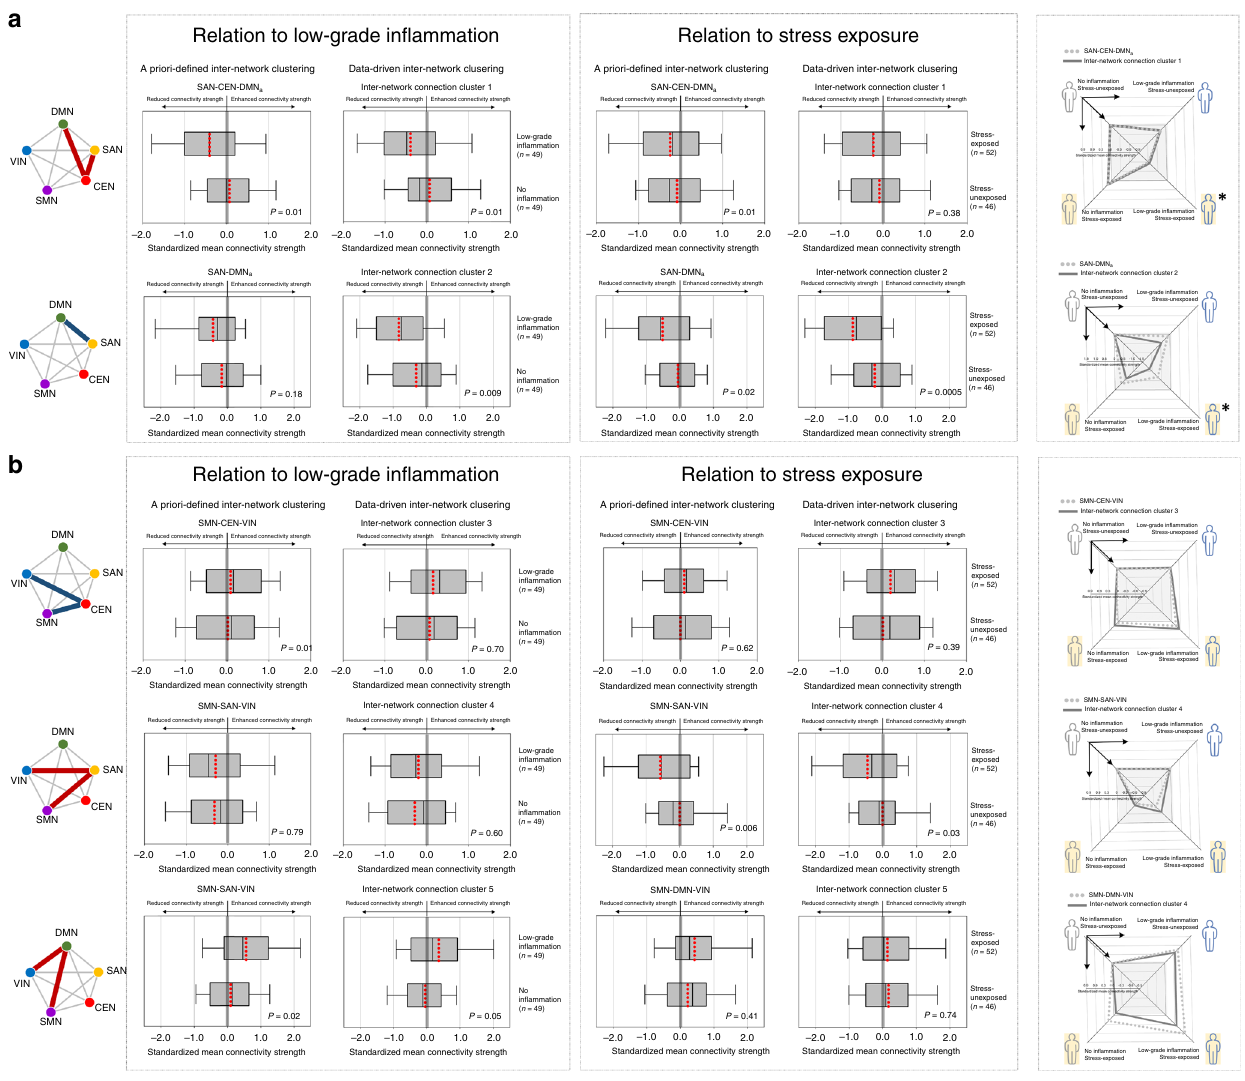
Fig. 4 Results from data set 2: altered inter-network connectivity strength in relation to low-grade in fl ammation and stress exposure. a Box-and- whisker plots show the distribution of standardized mean connectivity strength within the higher-order cognitive network system, including the SAN, CEN, and DMN a between the low-grade in fl ammatory ( n = 49) and the nonin fl ammatory groups ( n = 49) (left box), as well as the stress-exposed ( n = 52) and -unexposed groups ( n = 46) (right box). b Box-and-whisker plots show the distribution of standardized mean connectivity strength for the higher-order cognitive network system and the primary sensory network system between the low-grade in fl ammatory ( n = 49) and the nonin fl ammatory groups ( n = 49) (left box), as well as the stress-exposed ( n = 52) and -unexposed groups ( n = 46) (right box). Box-and-whisker plots represent the mean values (red dotted lines inside boxes), median values (black lines inside the boxes), the inter-quartile range (bottom and top ends of the boxes), and the 10th and 90th percentiles of the data (whiskers). Red and blue lines in the schematic diagram for inter-network connection clusters indicate the positive and negative coupling of networks, respectively. Group differences were calculated using the generalized linear models after adjusting for age and sex. P values (for two- sided testing) in the bar graph are permutation-adjusted P values (10,000 permutations). Radar graphs in panels a and b demonstrate comparisons of inter-network connectivity strength between the nonin fl ammatory/stress-unexposed group ( n = 24) and each of the remaining three groups, including the low-grade in fl ammatory/stress-unexposed ( n = 22), nonin fl ammatory/stress-exposed ( n = 25), and low-grade in fl ammatory/stress-exposed group ( n = 27), respectively. Asterisks indicate a statistically signi fi cant between-group difference in mean connectivity strengths obtained by both the a priori-de fi ned and data-driven inter-network clustering approaches. Source data are provided as a Source Data fi le. SAN salience network, DMN default mode